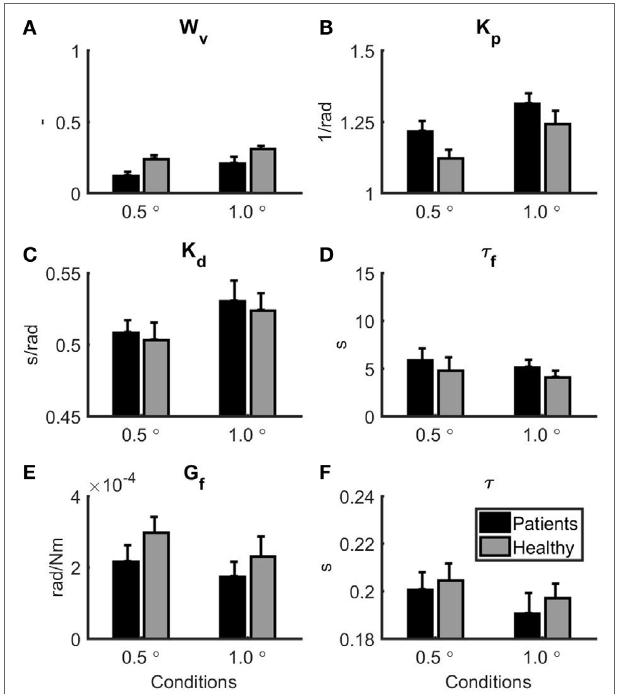
FigUre 3 | Parameter estimates for the patients with vestibular dysfunction (black) and healthy subjects (gray). 0.5° represents the 0.5° peak-to-peak condition and 1.0° represents the 1.0° peak-to-peak condition. Error bars represent SE. (a) Vestibular weight, (B) reflexive stiffness, (c) reflexive damping, (D) force feedback time constant, (e) force feedback gain, and (F) time delay.